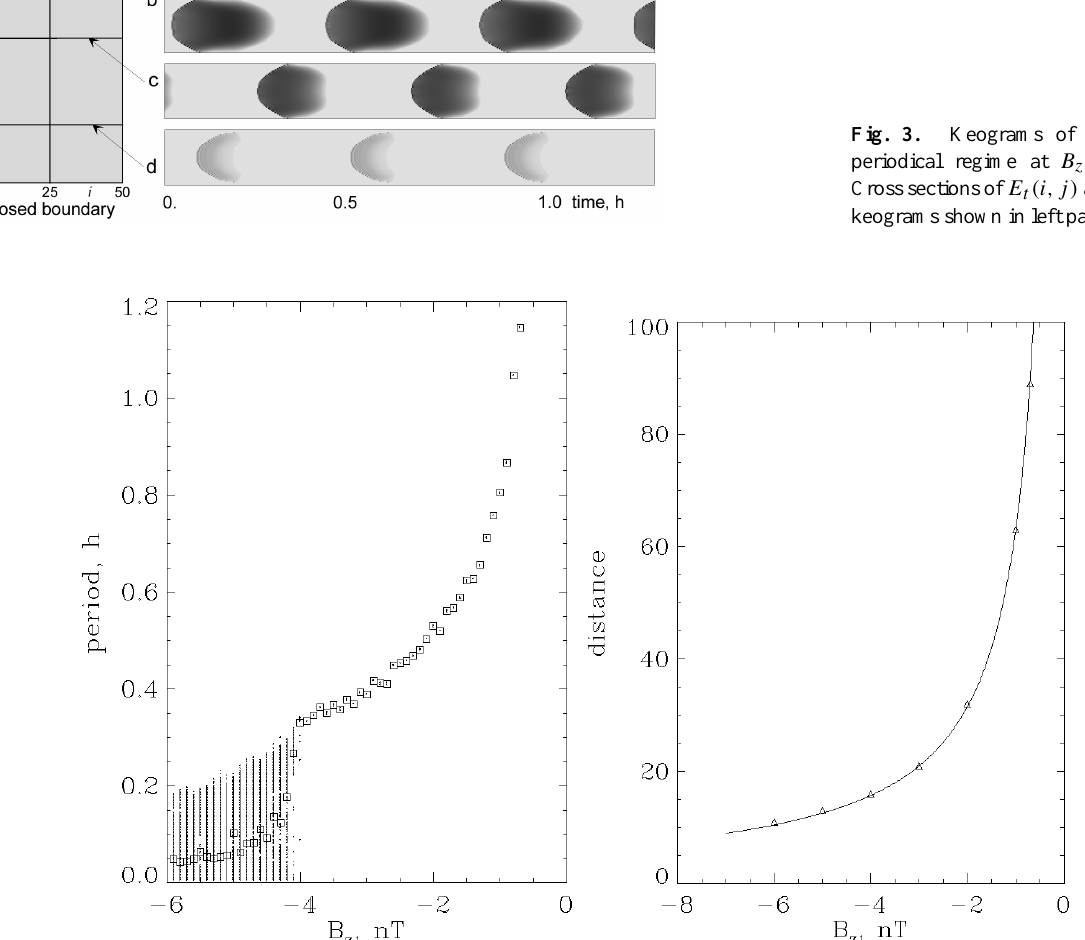
Fig. 4. Pseudo-periodical regime characteristics as a function of the parameter B z : (a) the inter-onset interval (dots) and the average transient period (squares); (b) the distance from the closed boundary to the onset point (triangles) and the approximation of this function using the Eq. (5) (solid